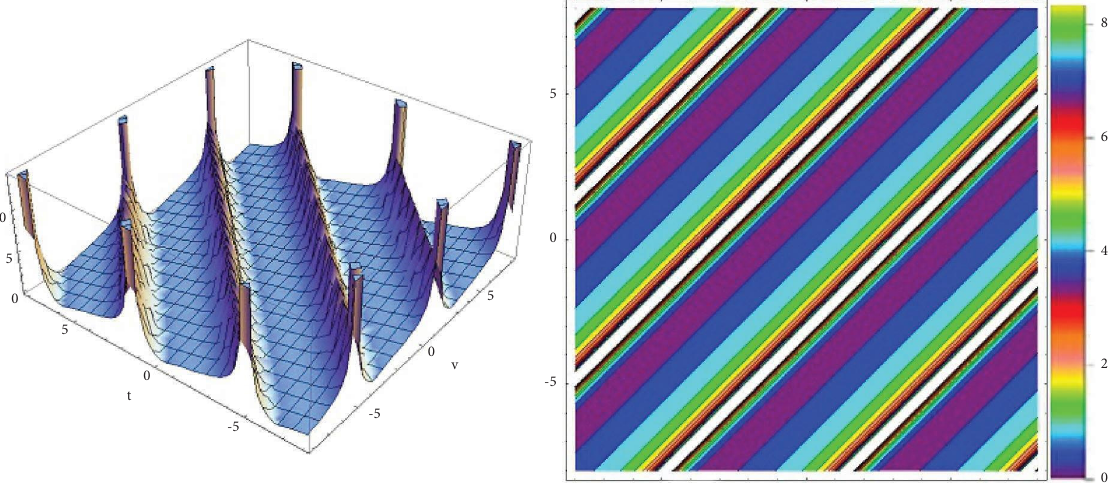
Figure 10: Singular periodic soliton depicted from (34) for ω � 1.